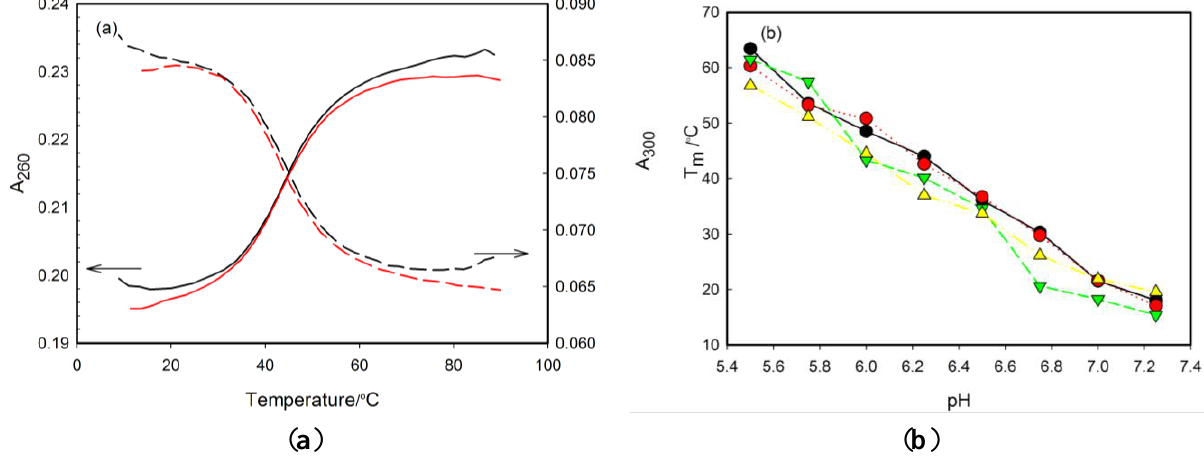
Figure 2. ( a ) The melting profile of 1tC probe at the pH 6.25. The presented curves illustrate cooling (black lines) and heating (red lines) experiments recorded at 260 nm (solid lines) and at 300 nm (dashes lines). The scales for the 260 nm and 300 nm readings are notably different. ( b ) Temperature melting values of tC-modified– probes: 1tC (red), 3tC (green) and 6tC (yellow) and unmodified 5′-(C 4 G) 3 C 4 A-3′ sequence (black) plotted against